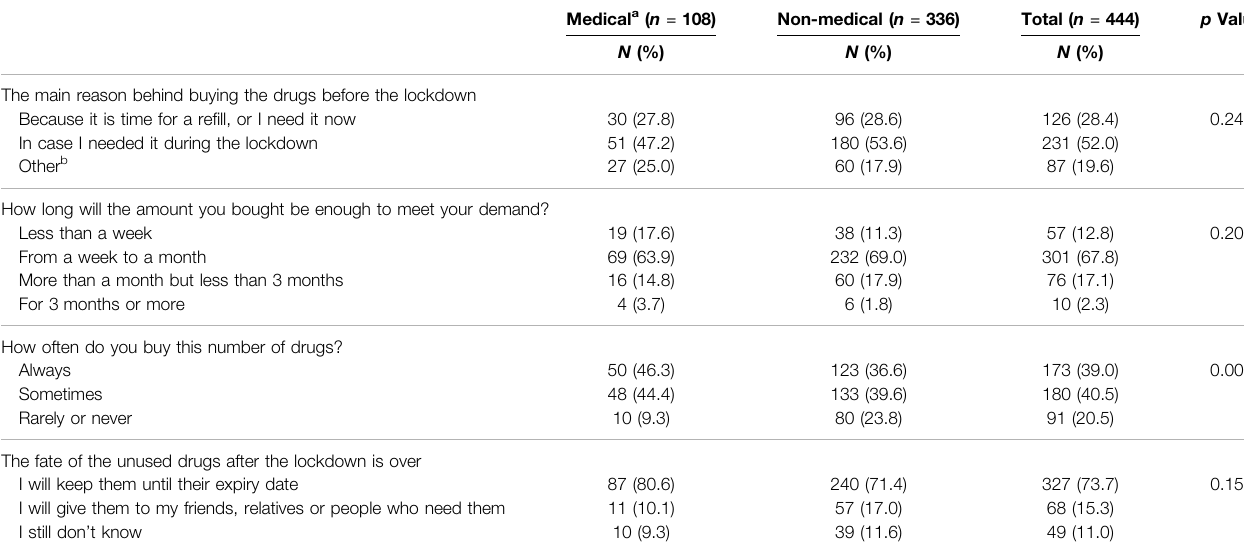
TABLE 2 | Effect of educational background on the practice of drug purchasing and